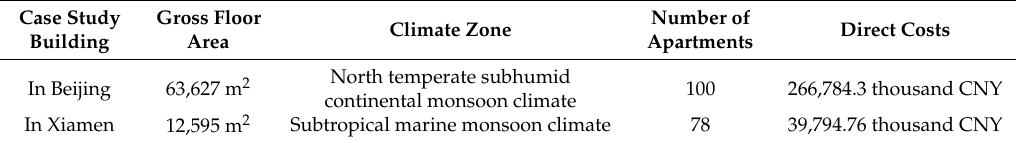
Table 8. Comparison of the case study buildings in Beijing and